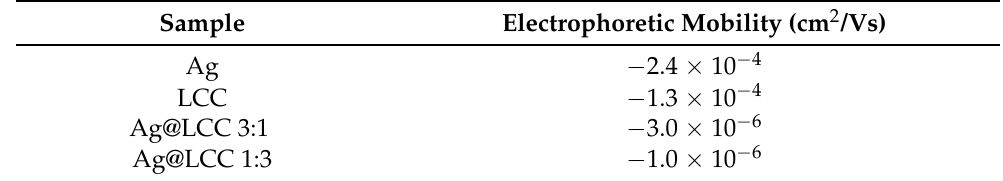
Table 1. Mean electrophoretic mobility for the studied dispersions. The standard deviation is within 10%.